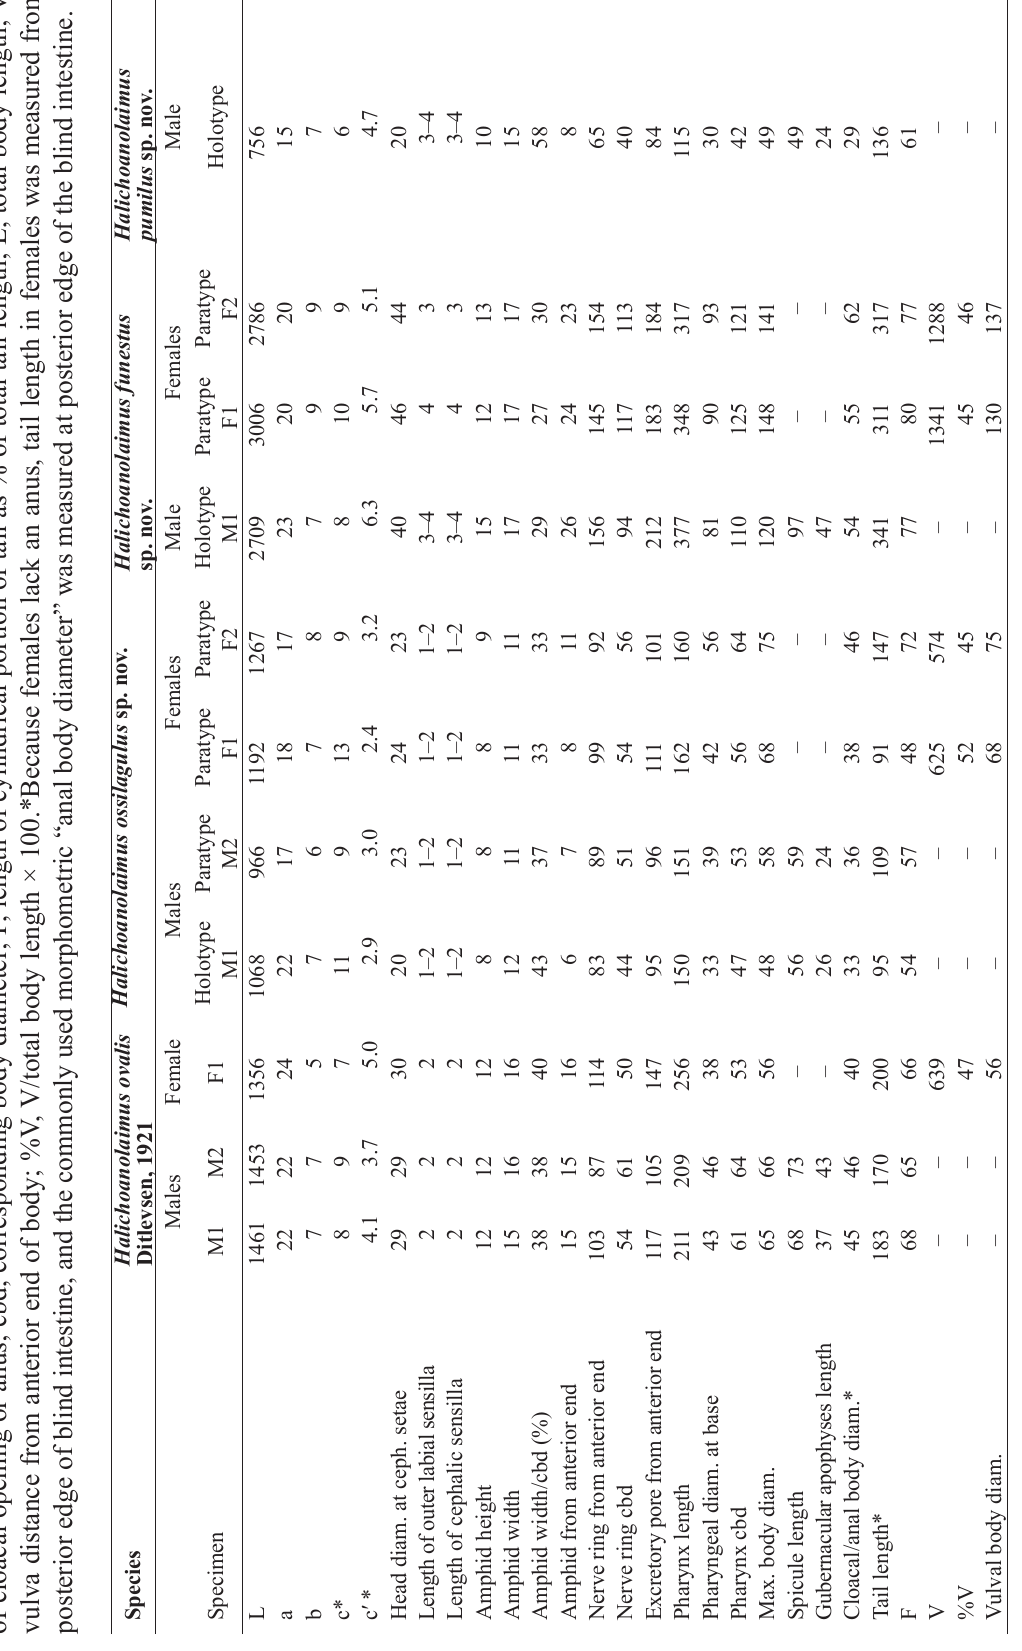
m o fr d e u r s ea m s a w s e a l m e f n i h ng t e l il a t s , nu a n a k ac l s e a l m e f e s u eca B * 100 . × h ng t e l body a l o t /t V V , % body ; o f nd e o r i e r n t a m o fr e c n a s t d i a v vu l